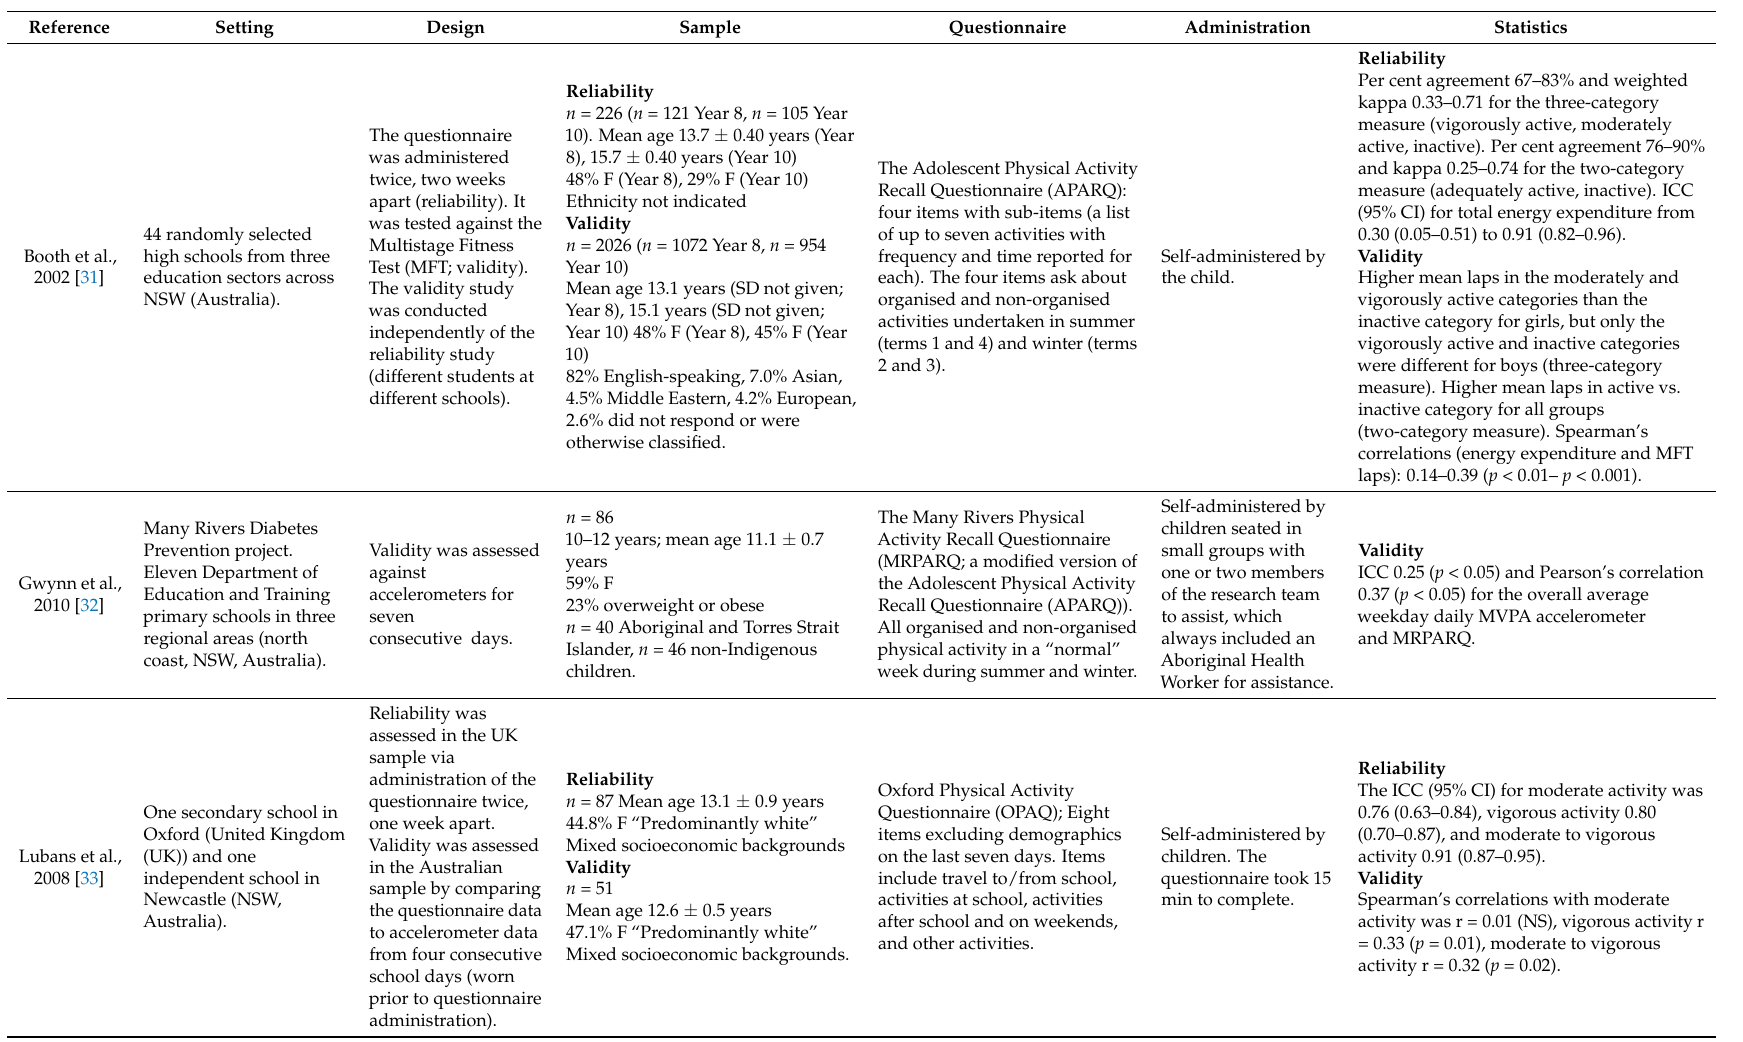
Table 2. Physical activity and sedentary behaviour questionnaires included in the review from peer-reviewed journal articles *.